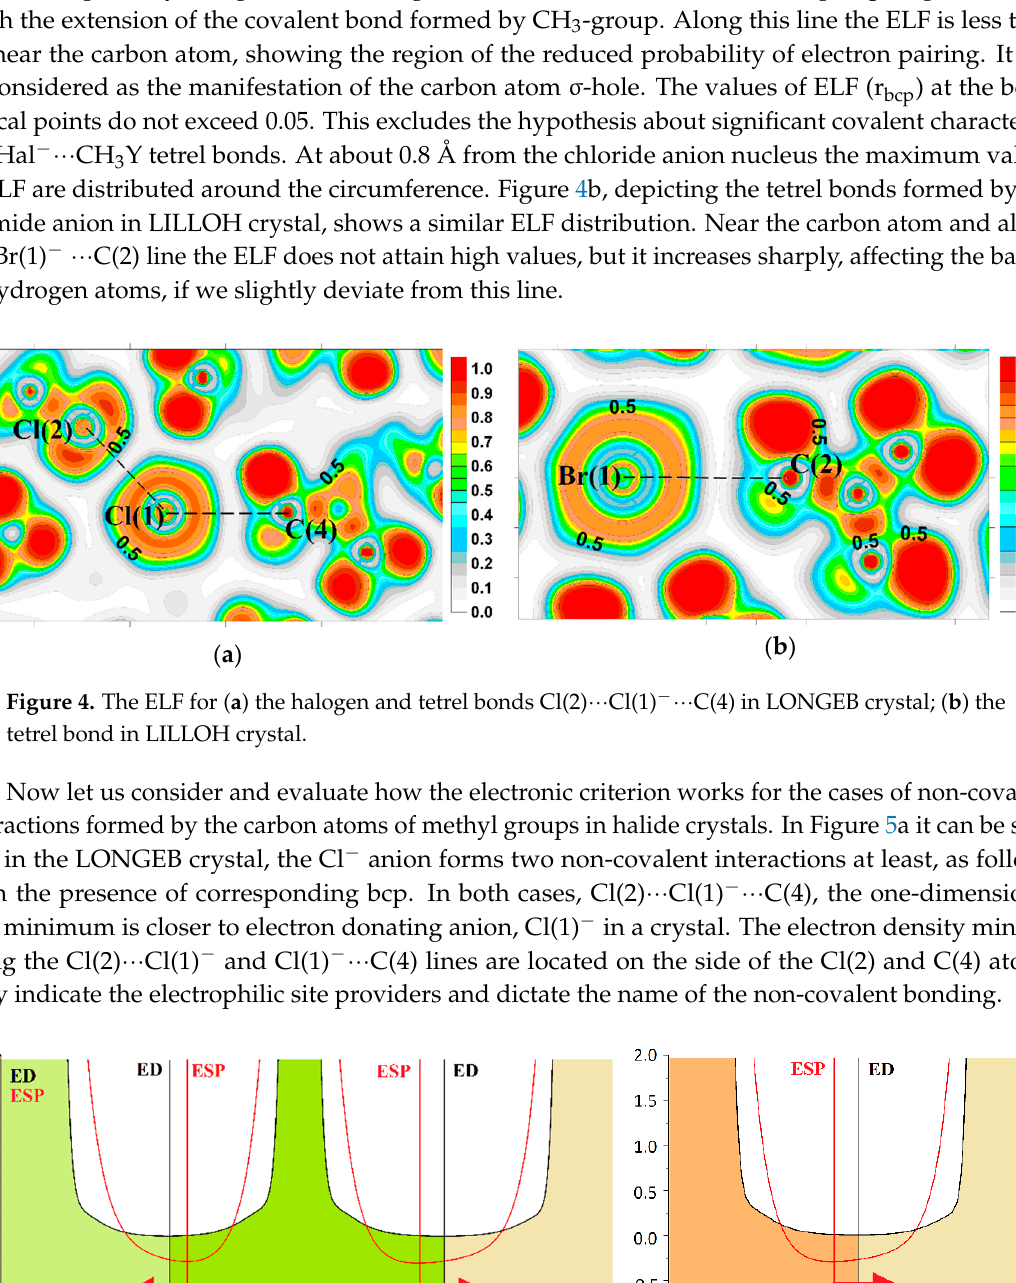
Figure 3. (a ) ESP in the trimethylammonium cation on the isosurface of electron density of 0.003 a.u.; ( b ) contour map of ESP in the plane N-C-H, red point indicates the maximum of ESP on the van der Waals surface (red line) and belongs to C atomic basin.